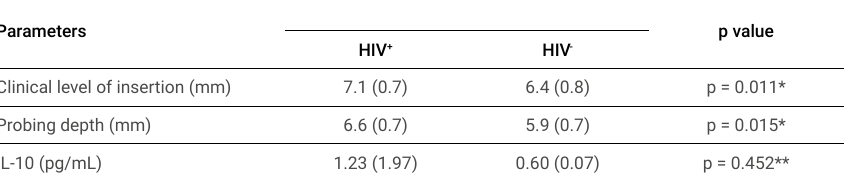
Table 1. Mean values and standard deviation of cytokine and clinical parameters of chronic periodontitis among HIV-1 seropositive and seronegative